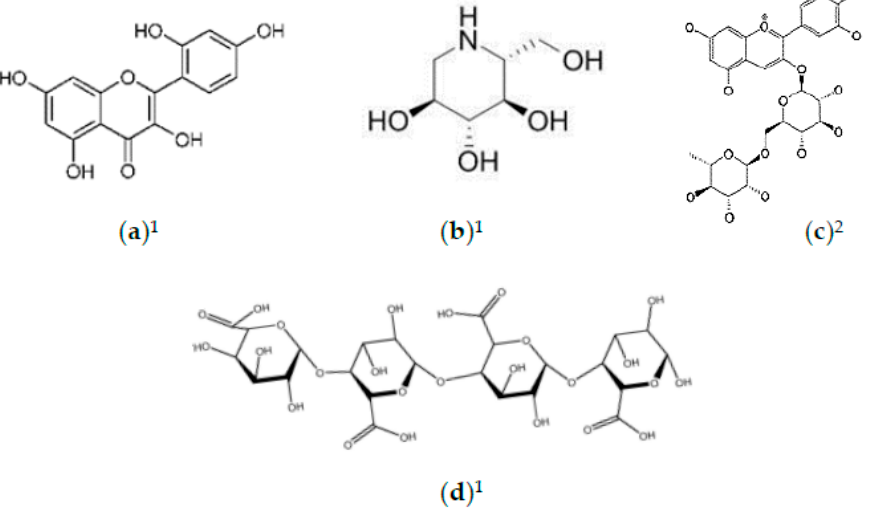
Figure 5. Natural compounds in M. alba possessing antimicrobial and antiviral activities. ( a ) Morin; ( b ) 1-deoxynojirimycin (DNJ); ( c ) cyanidin-3-O-rutinoside; ( d ) pectin. 1 Refers to compounds in M. alba fruit; 2 refers to compounds in M. alba seeds.